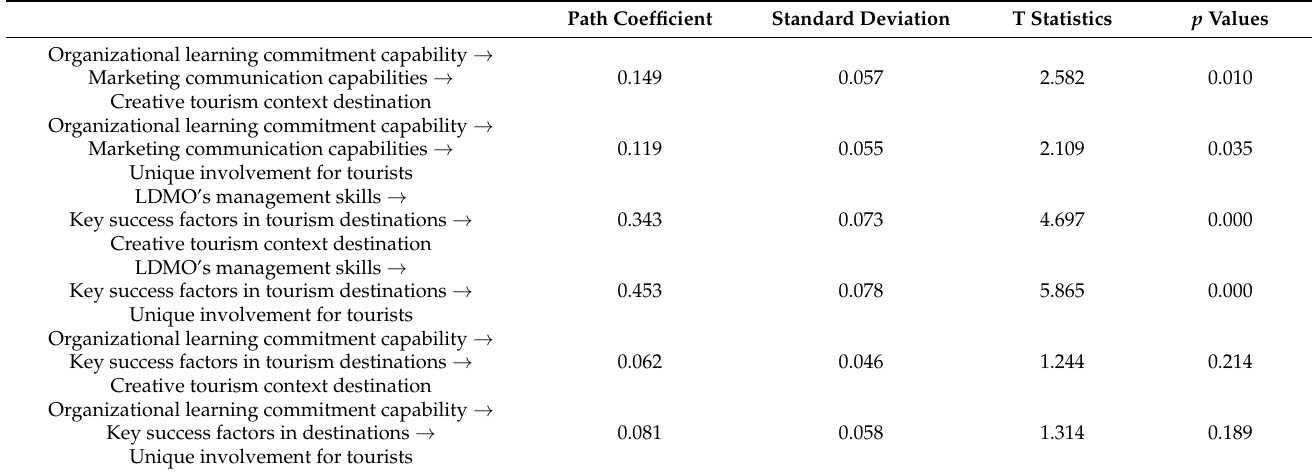
Table 3. Bootstrap results for indirect